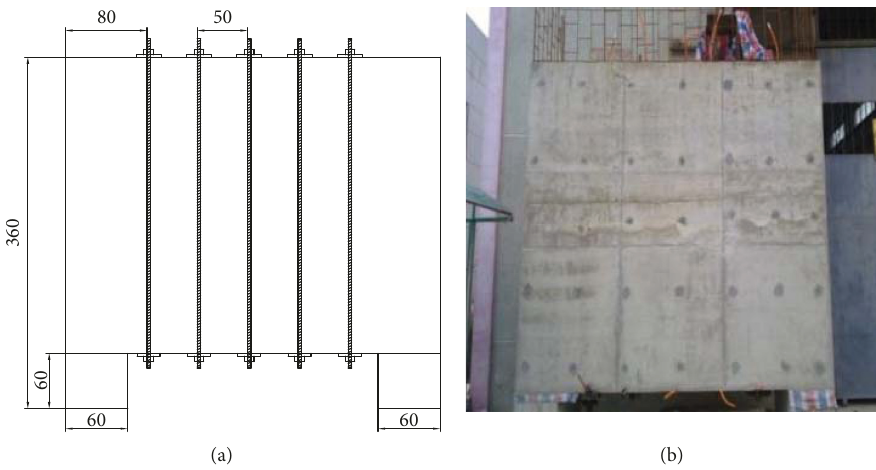
Figure 6: Experimental model developed for vertical P/S FSSB: (a) overall view (unit: cm) and (b) photo.